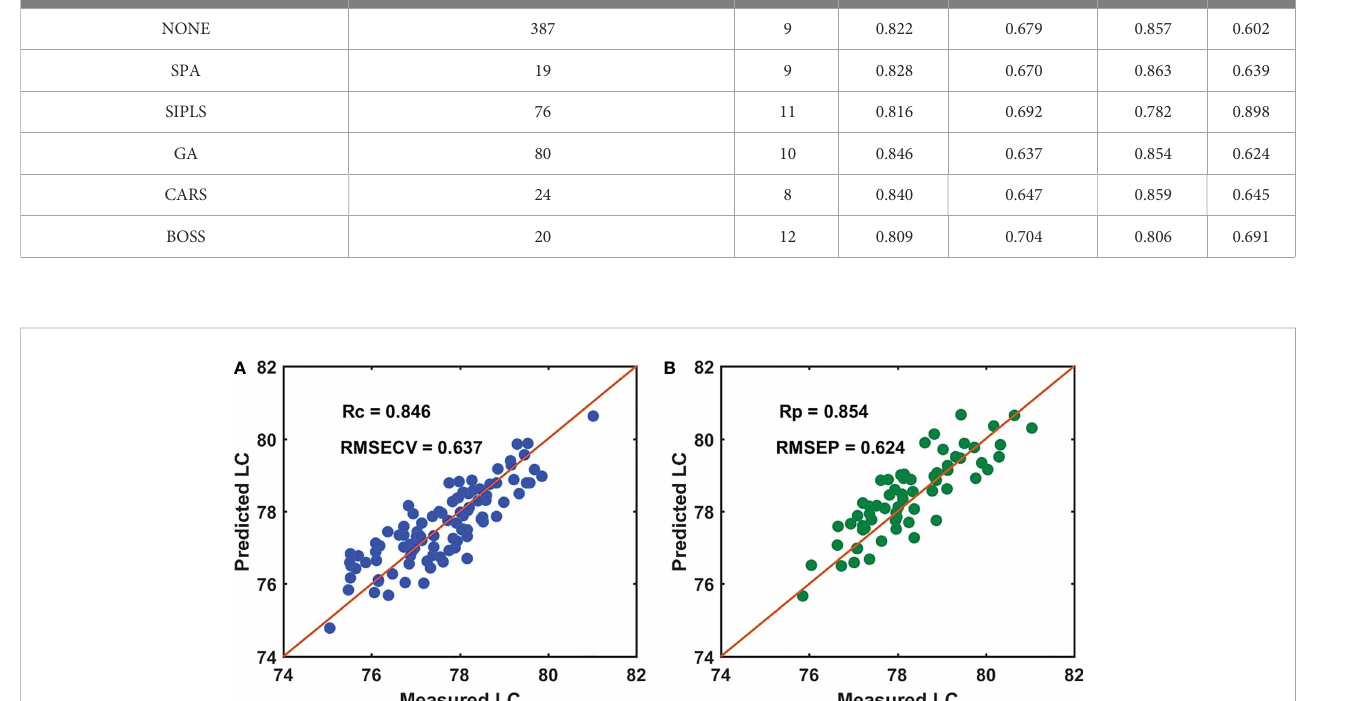
FIGURE 5 Performance of the SNV-GA-PLSR model for measuring the LC of batch A samples. (A) the calibration set, and (B) the prediction set.